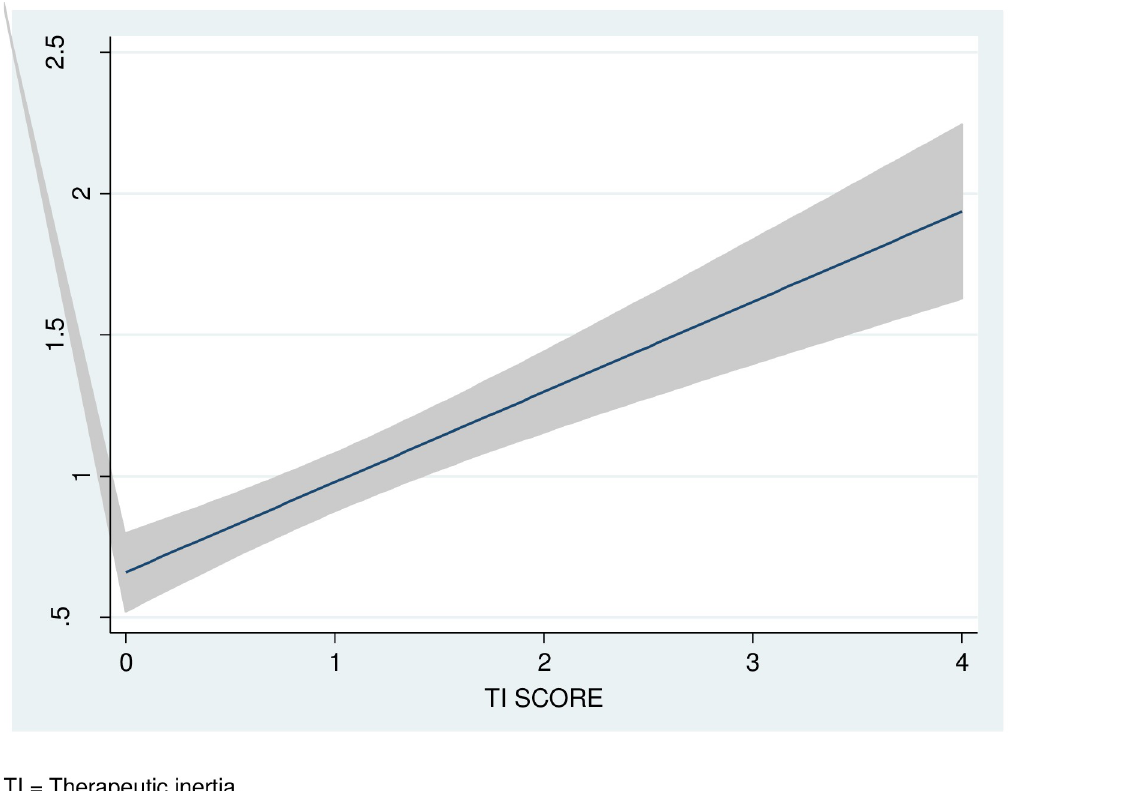
Fig 1. Observed versus predicted probability of therapeutic